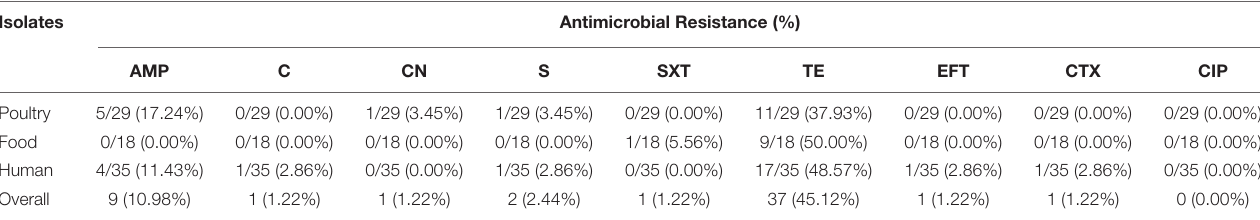
TABLE 1 | Distribution of phenotypic antimicrobial resistance (AMR) profile among S . Enteritidis isolates. Isolates